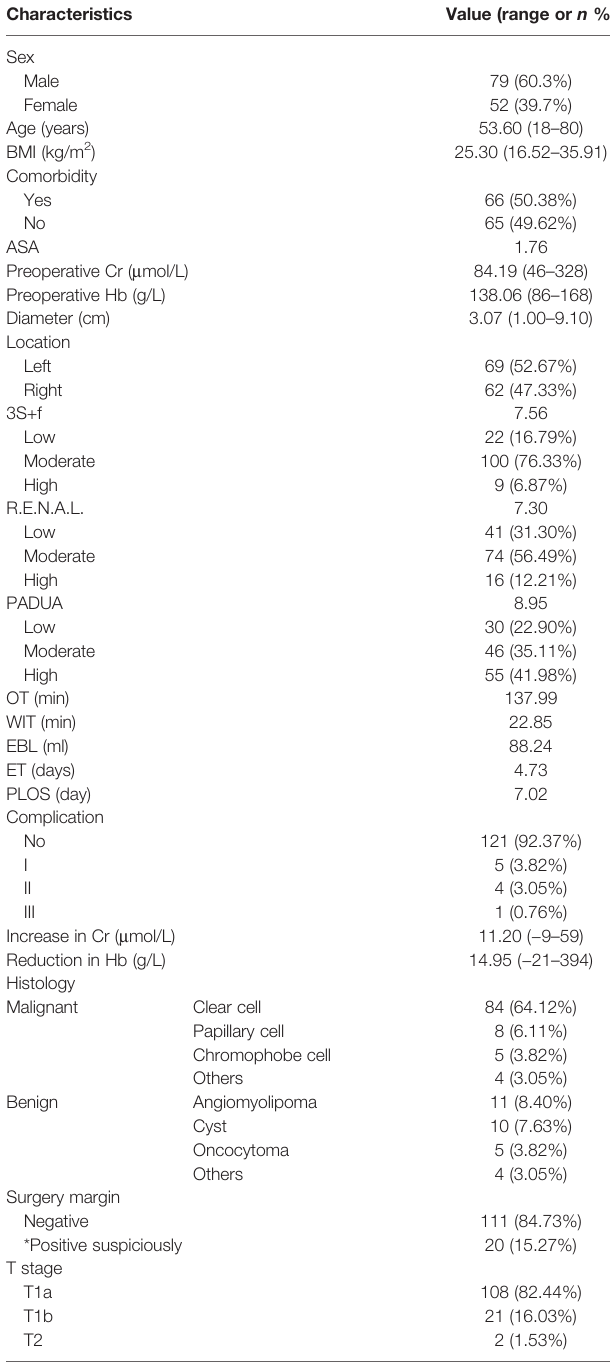
TABLE 2 | The demographic and clinical characteristics of the